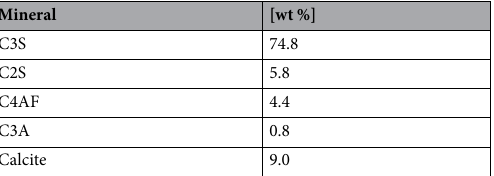
Table 4. Mineral composition determined by XRD-Rietveld analysis of the cement studied in this